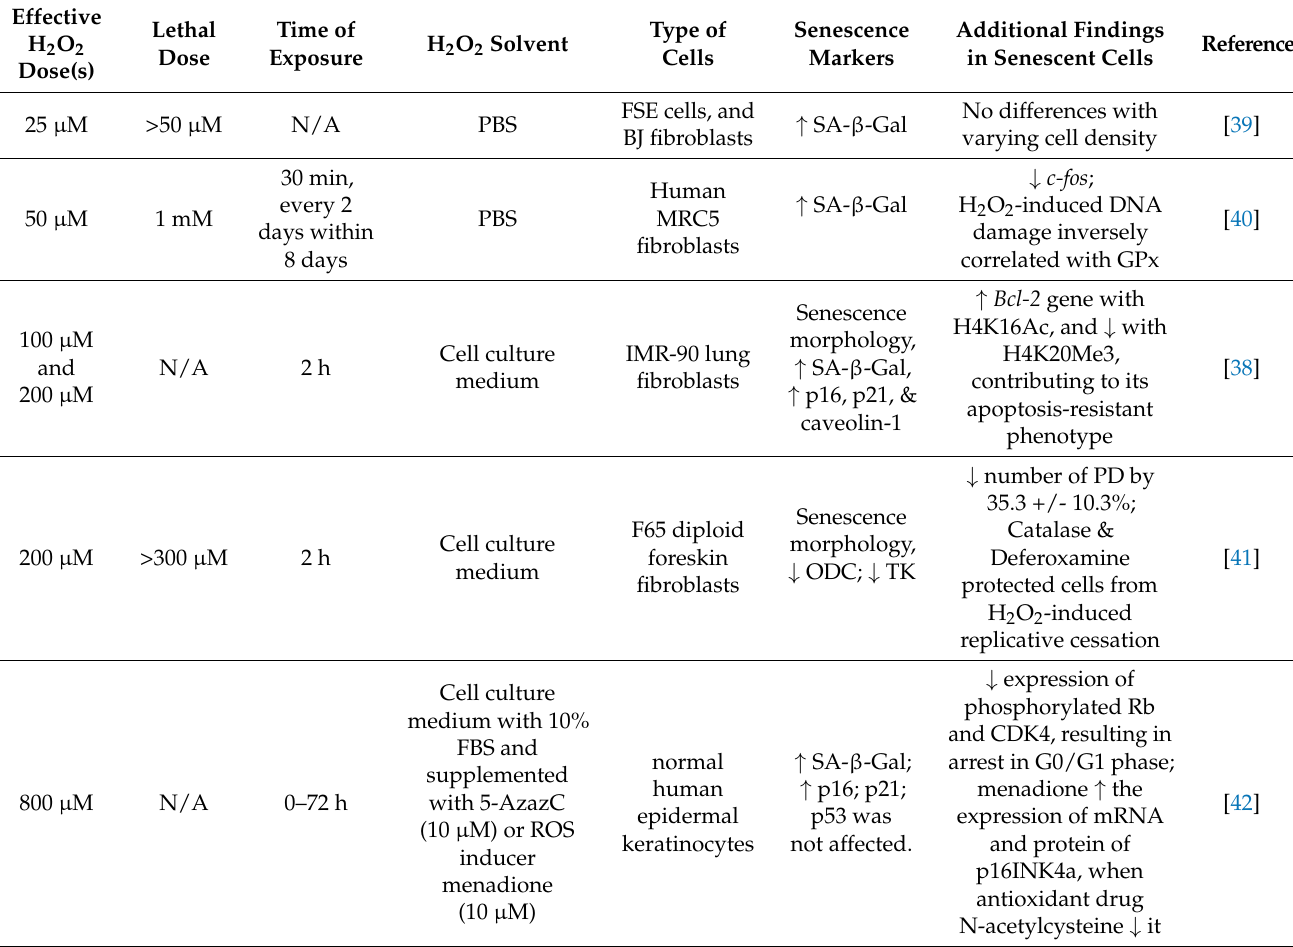
Table 1. In vitro H 2 O 2 stress-induced senescence